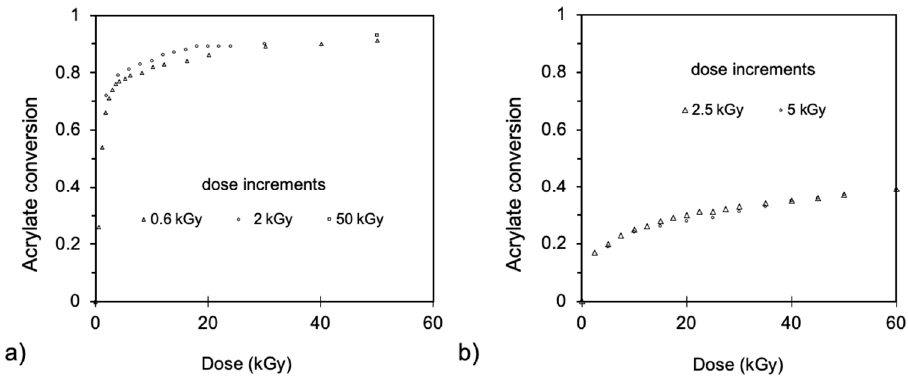
Figure 3. Kinetic profiles of acrylate consumption in prepolymer films as a function of EB-radiation dose: ( a ) APU and ( b ) EPAC.